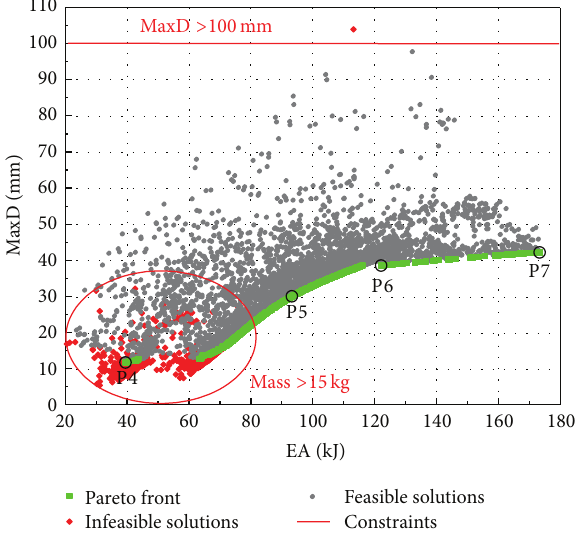
Figure 15: Optimization results of Case Study